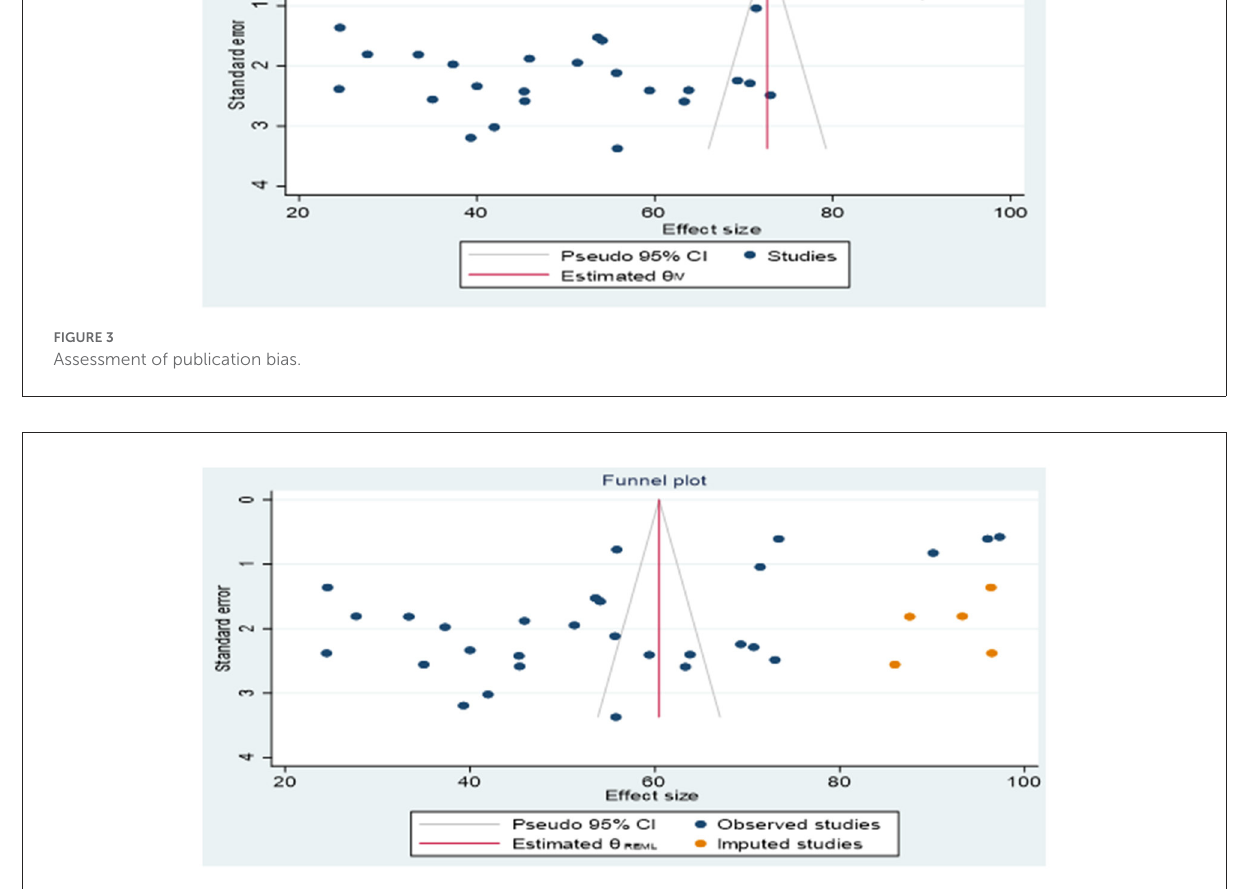
FIGURE4 Funnel plot for publication bias after